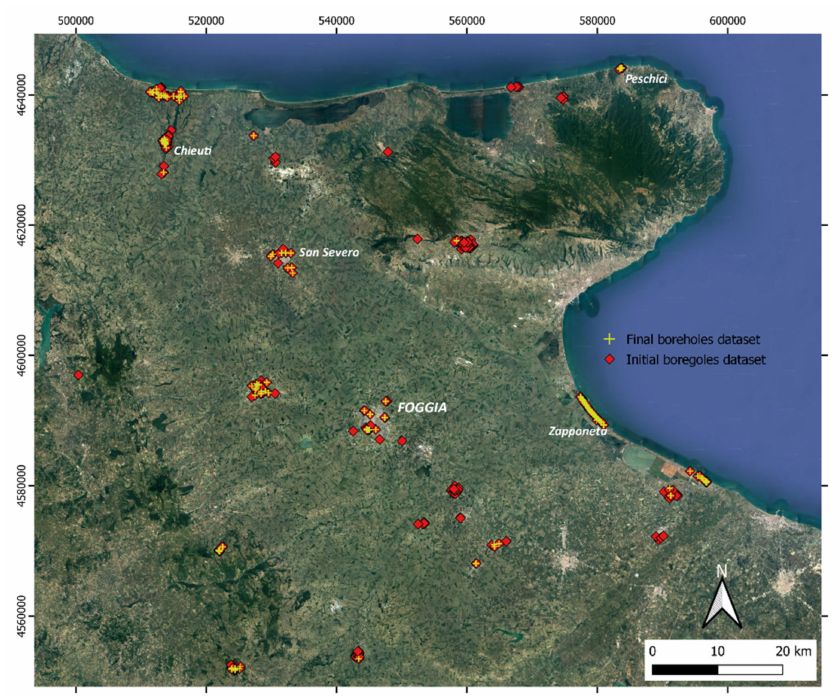
Figure 3. Location of the available boreholes and the final subset of 166 more reliable boreholes selected for the